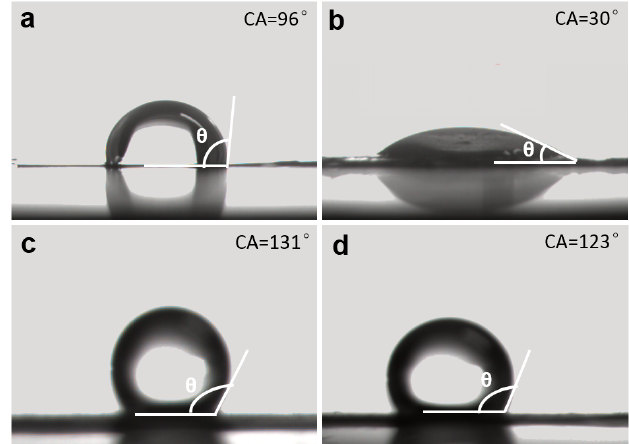
Figure 10. Images of water contact drops for different samples: ( a ) original GR; ( b ) CV treated GR; ( c ) SA treated GR ( d ) SA treated GR after immersion in 3.5 wt.% NaCl for 24 h.